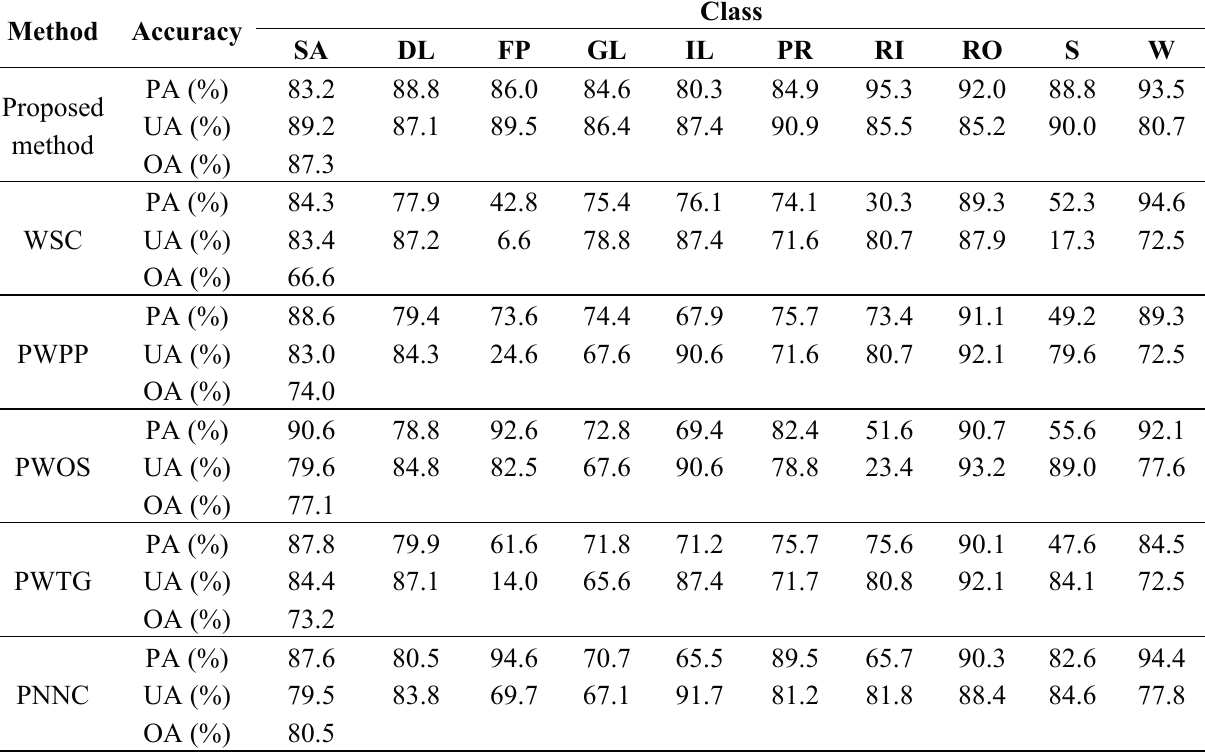
Table 2. Classification accuracy. SA, sand; DL, dry land; FP, fish pond; GL, grassland; IL, irrigable land; PR, paddy rice; RI, river; RO, road; S, sea; W, wetland vegetation;